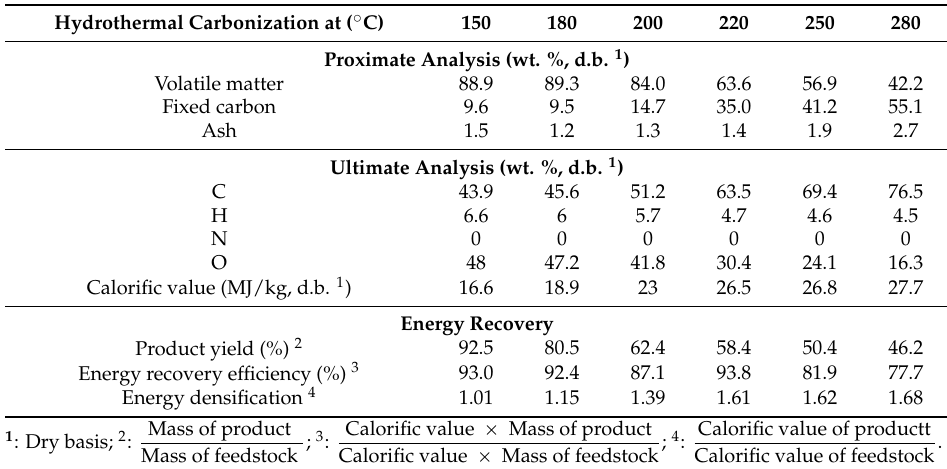
Table 3. Effects of hydrothermal carbonization on changes in cellulose